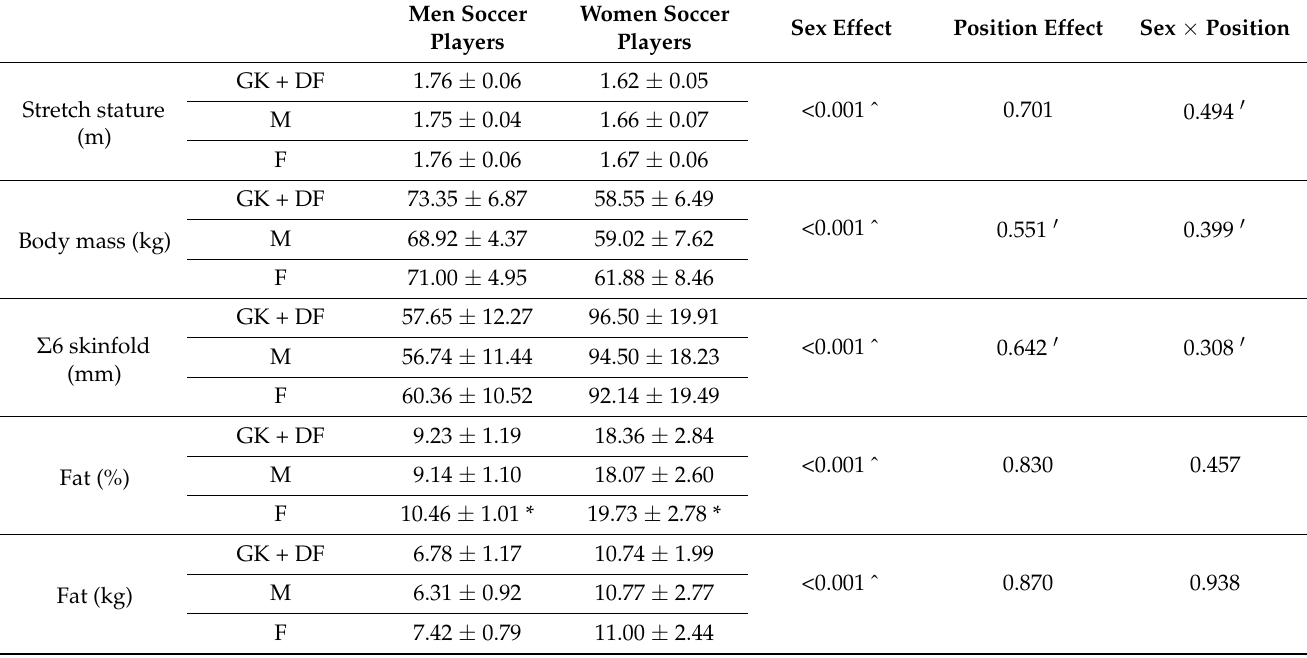
Table 2. Anthropometry and body composition according to sex and playing position. Men Soccer Women Soccer Sex Effect Position Players Players